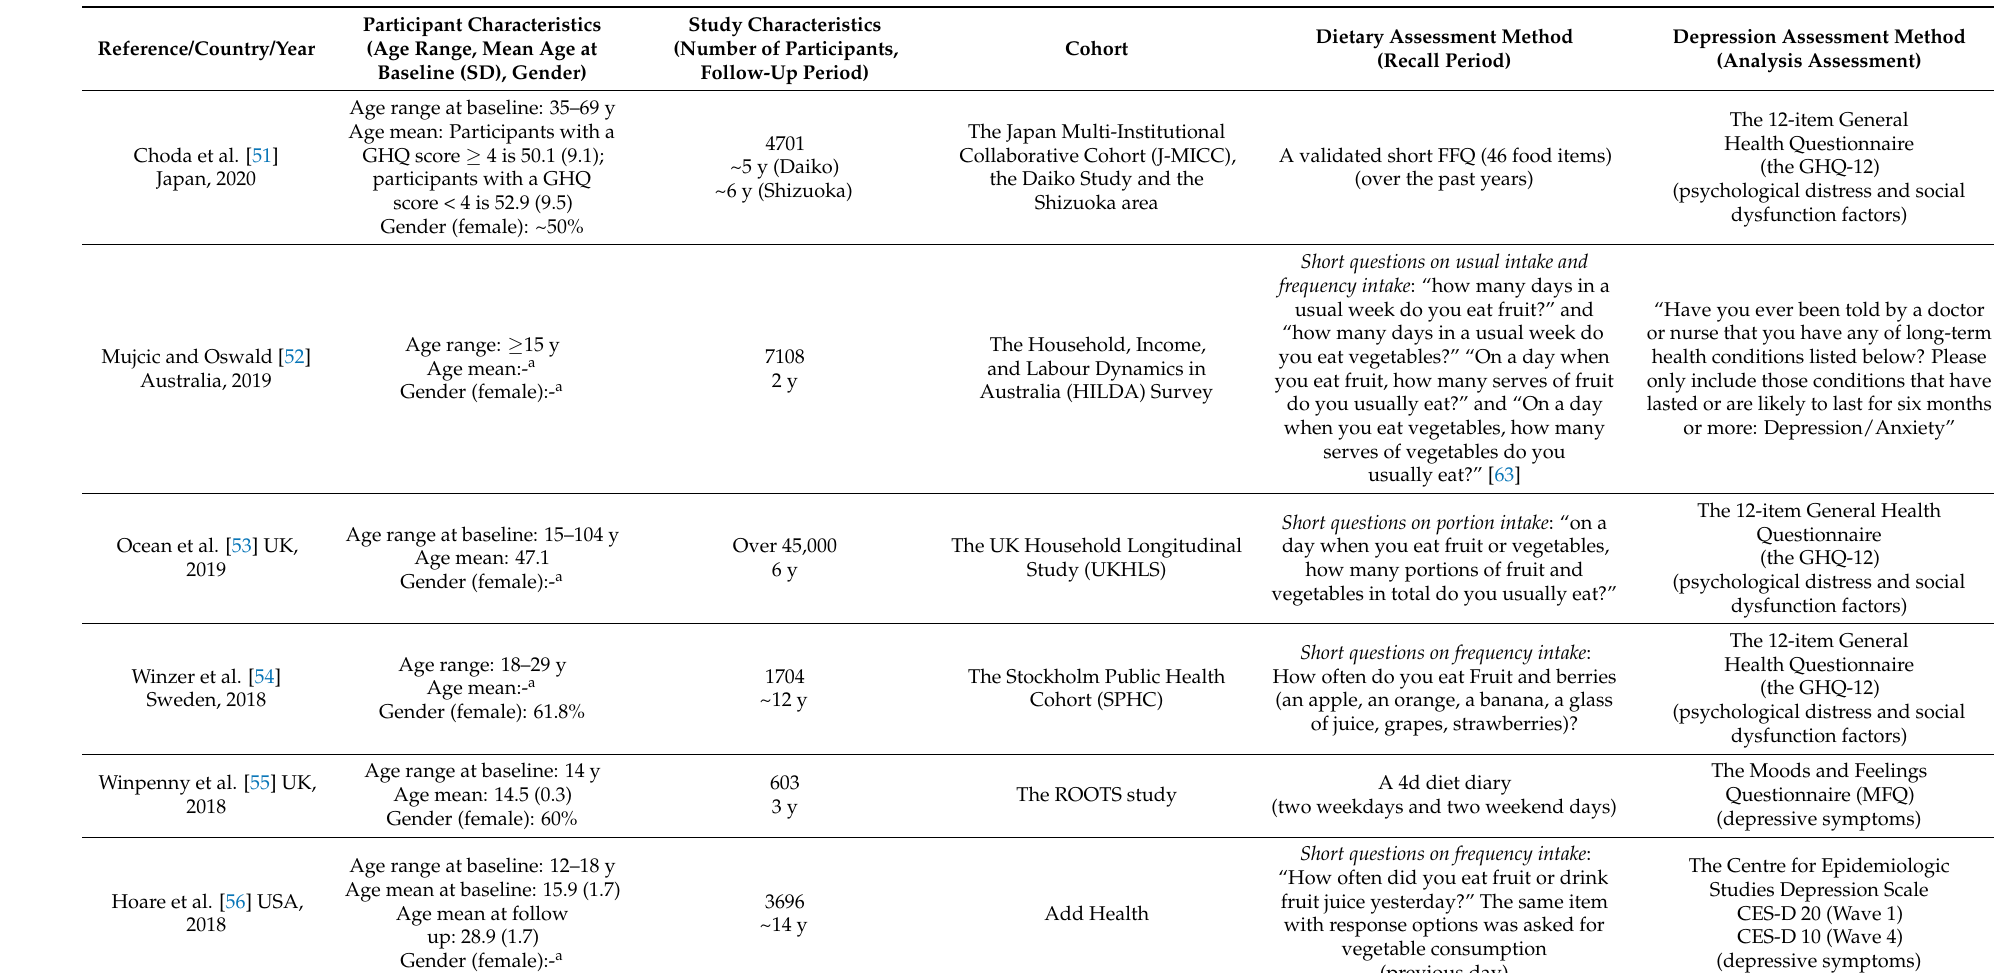
Table 1. Characteristics of included